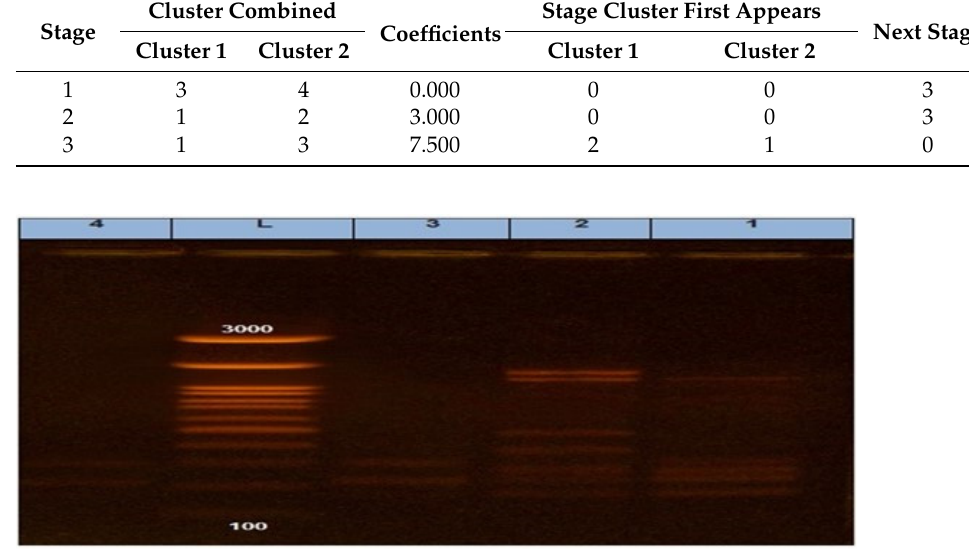
Figure 4. ERIC PCR showing different bands in each isolate.